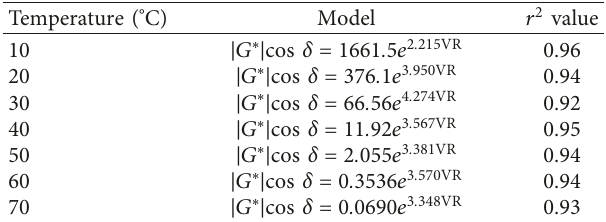
G cos δ and VR for the limestone | | ∗